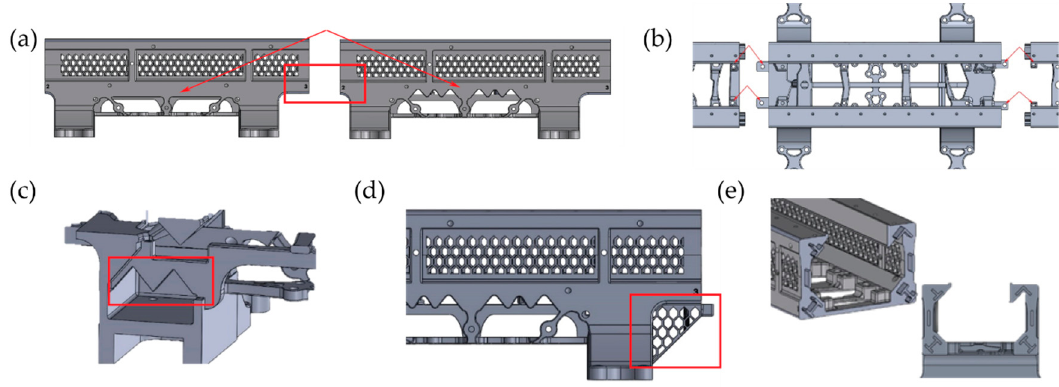
Figure 5. Modifications of the part features according to the support optimization procedure presented in Section 2. ( a ) modification of the bottom part of the rail to reduce the number of support structures; ( b ) removing material and modification of the surfaces to avoid inaccessible area for the support removal (a section is showed in ( c )) and adding a link to improve the assembly strength; ( d ) features that support the overhang both during the construction of the part and the working conditions; ( e ) particulars of the shaft–hub interference fit (details are provided in the supplementary file).